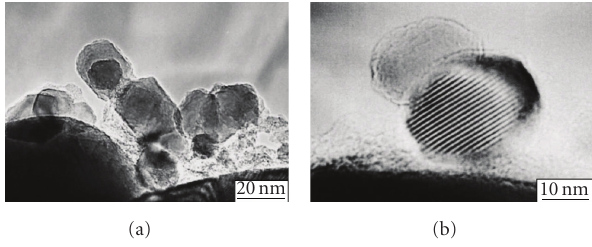
Figure 5: TEM images of carbon-coated TiO 2 prepared from TiO 2 and PVA.